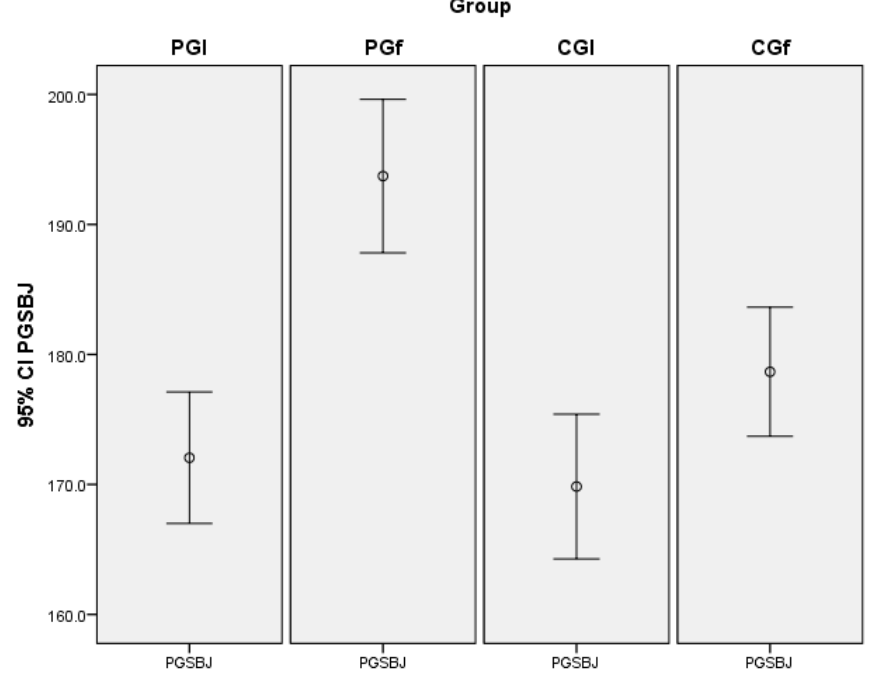
Figure 4. Standing long jump means between the PG and CG groups.